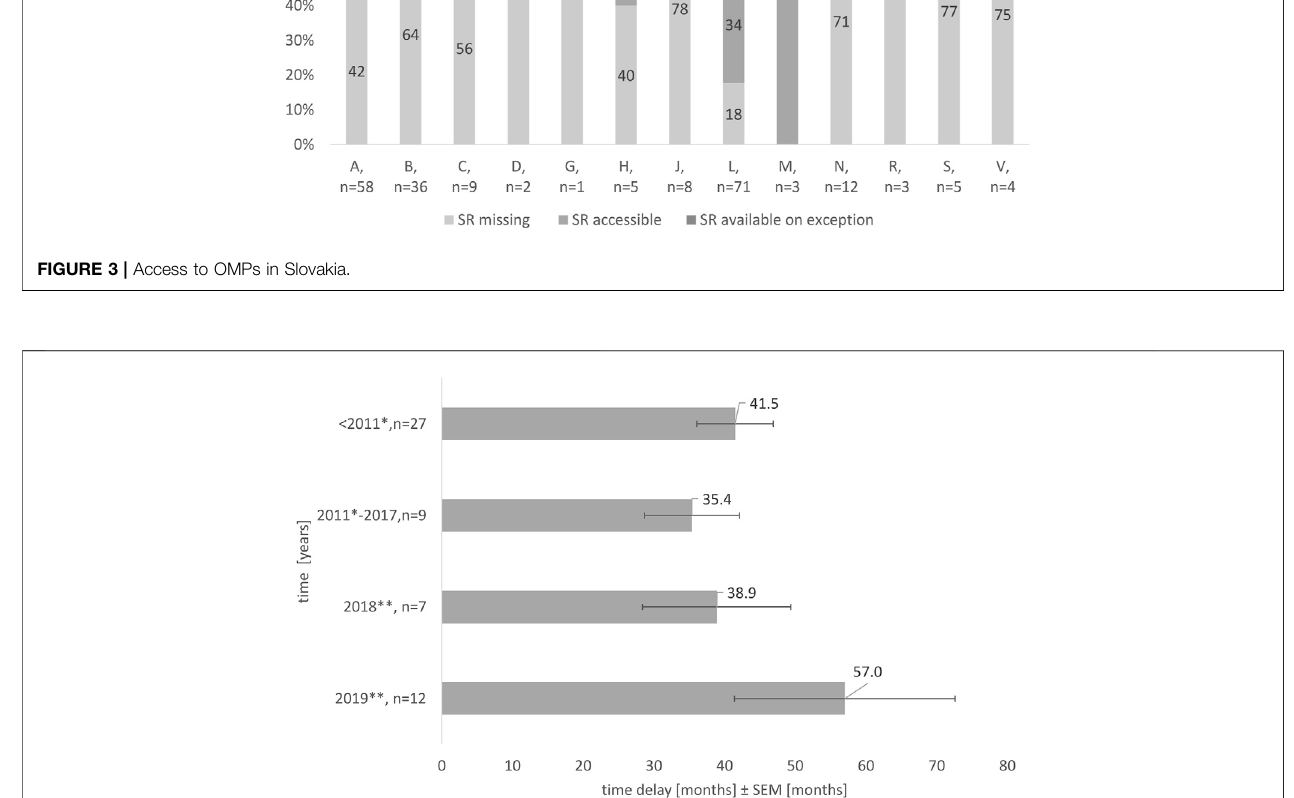
FIGURE 4 | Average time delay in access to OMPs in Slovakia, the impact of the health reform, and novelization of the pricing and reimbursement Act, SEM = standard error of the mean, * New pricing and reimbursement Act, ** Novelization of the pricing and reimbursement Act.